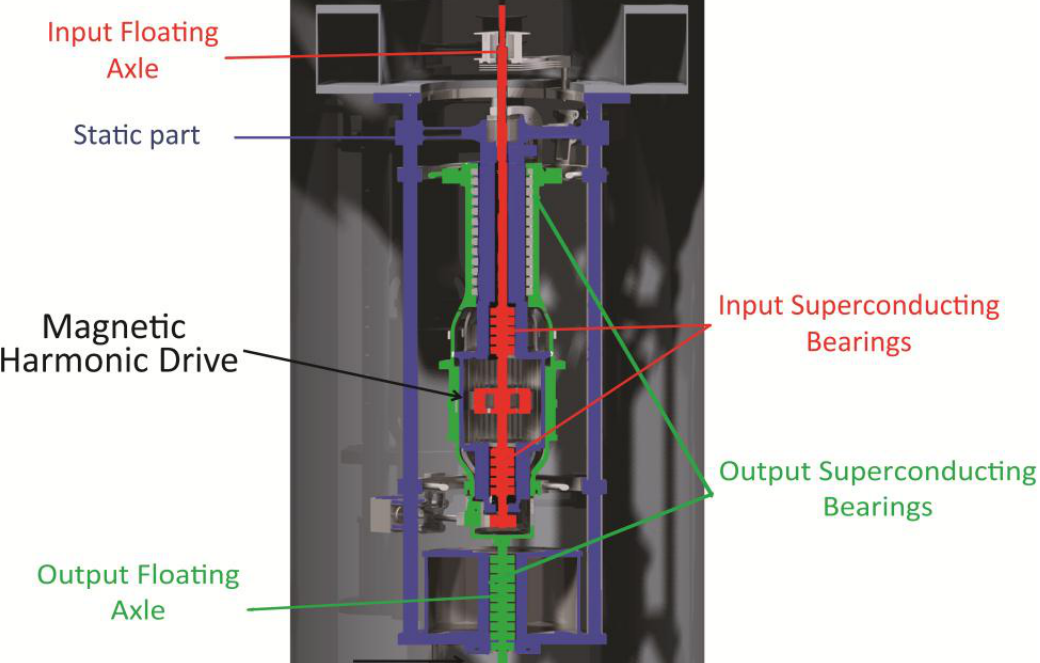
Figure 4. Mechanical model of the prototype including magnetic harmonic drive and